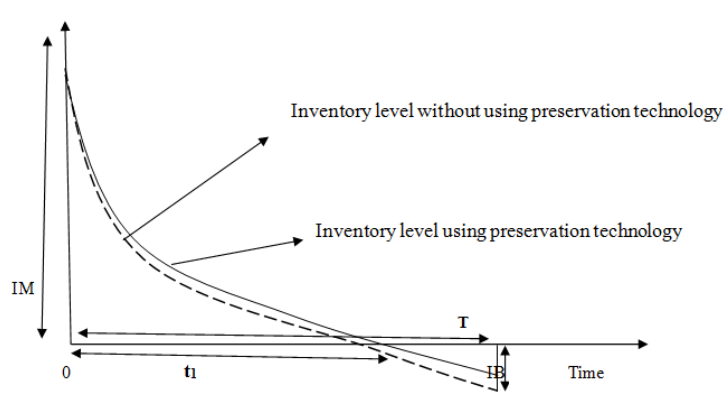
Figure 1. Graphical Representation of Inventory